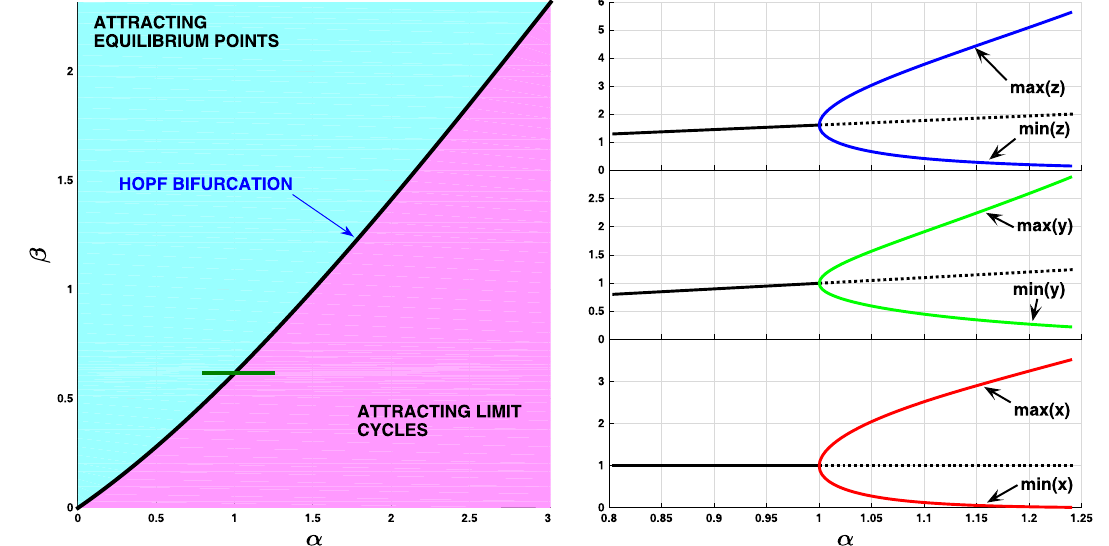
Figure 3. Bifurcation diagram of the Coimbrator. Left panel: the Hopf bifurcation is supercritical and the oscillations arise for parameter values to the bottom-right side of the bifurcation curve. Right panel: the onset of the cycle as α increases along the green segment ( β = 0.6180) depicted in the left panel ( z = blue, y = green, x =